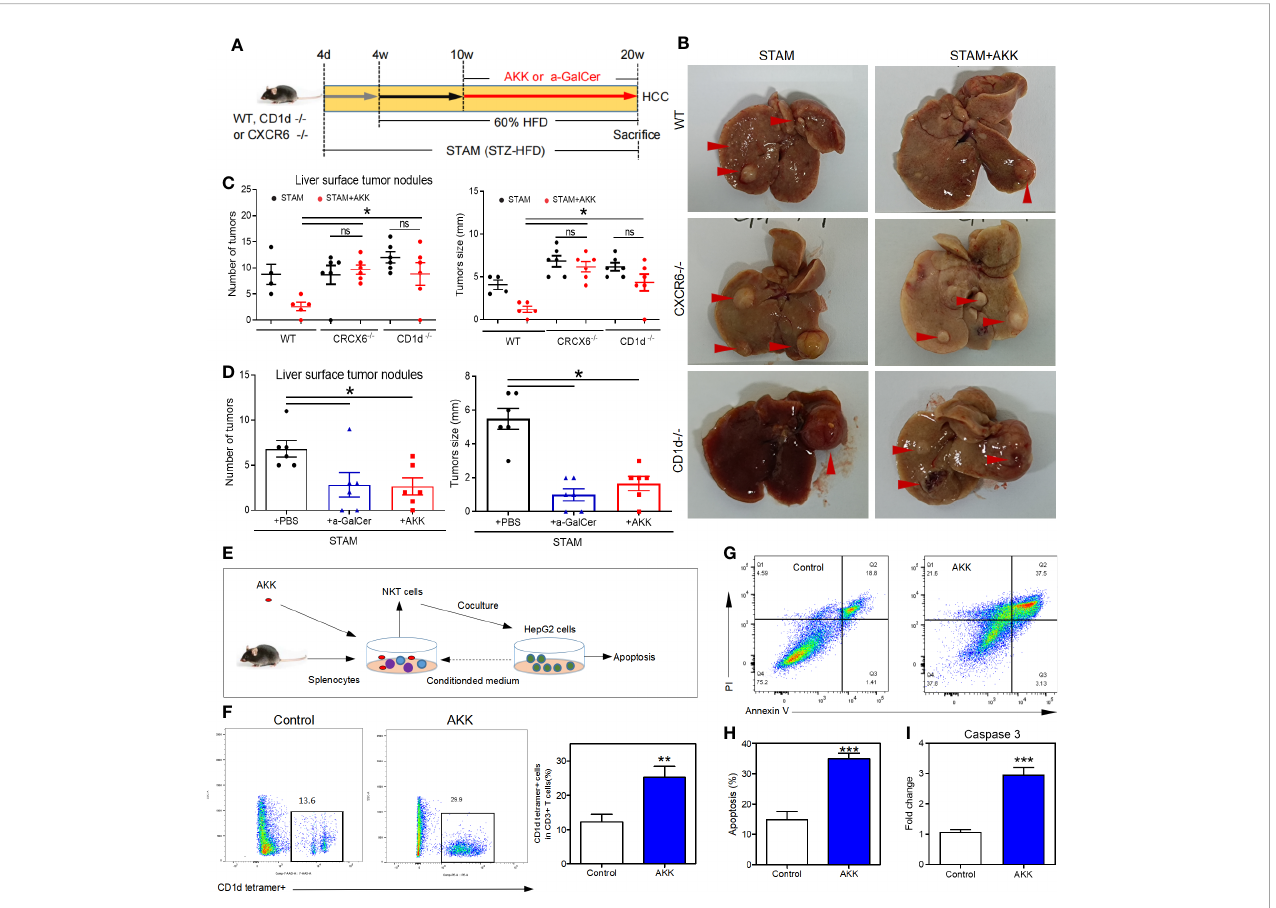
FIGURE 6 A muciniphila inhibit NASH-related HCC through NKT cells. (A) Experimental design and protocol. CD1d − / − (n=6), CXCR6 − / − (n=6) or wild-type mice (n=4 or 5) were treated with A muciniphila , a-GalCer (postive control) or saline (placebo-control) for 10 weeks starting at 10 weeks of age twice a day. Mice were killed at 20 weeks of age. (B) Macroscopic images of the liver surface (arrowheads: tumor). (C, D) The total number of tumor nodules on the liver surface were counted and the maximum diameter of the tumor nodules in the liver were measured. (E) Experimental design and protocol of in vivo experiments. (F) The fraction of NKT cells in the splenocytes was cultured with HepG2 cell conditioned medium with or without A muciniphila for 72 hours. (G, H) The percentage of apoptotic HepG2 cells was measured by fl ow cytometry. Data represent mean ± SEM of two pooled experiments. (I) The mRNA expression of caspase 3 in HepG2 cells was detected by qPCR. *P < 0.05. **p<0.001, ***p<0.0001 by unpaired Student ’ s t test.